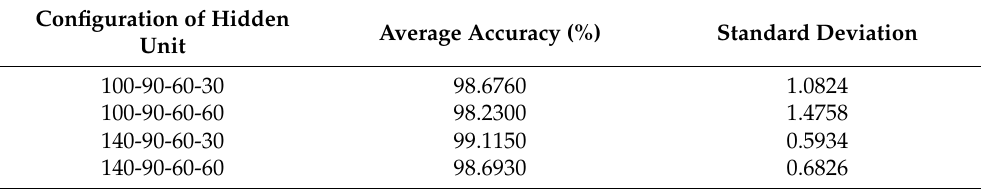
Table 5. The classification results according to changes in hidden units of the 1D CNN–GRU with the C5G4 *